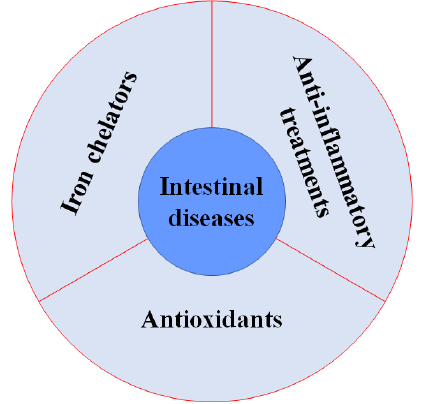
Figure 5. Treatments for intestinal diseases. Therapeutic targets for intestinal diseases associated with iron overload and ferroptosis, including iron chelators, antioxidants and anti-inflammatory